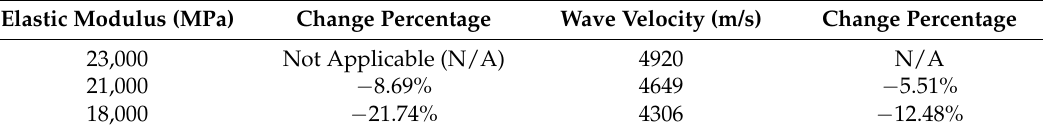
Table 4. Study on elastic modulus for isotropic material model.